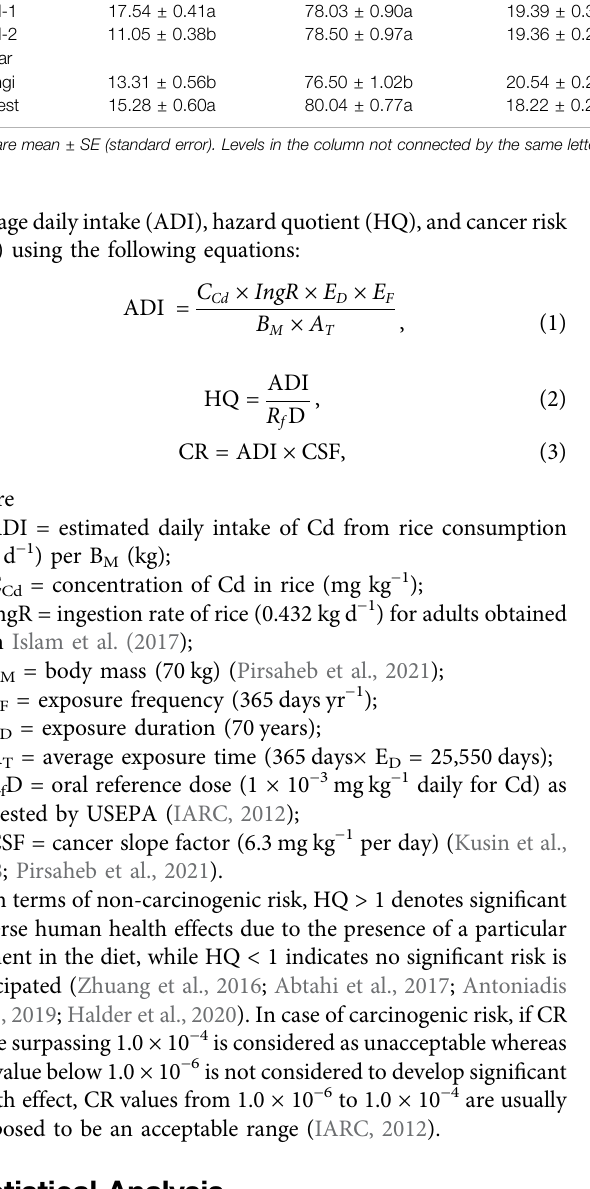
TABLE 2 | Effect of soil and rice cultivar on yield components and yield of rice cultivar. Fators Yield components Yield Number of Plant height Panicle length Filled Straw yield Grain yield tiller/hill (cm) (cm) grains/Panicle (g/plant)